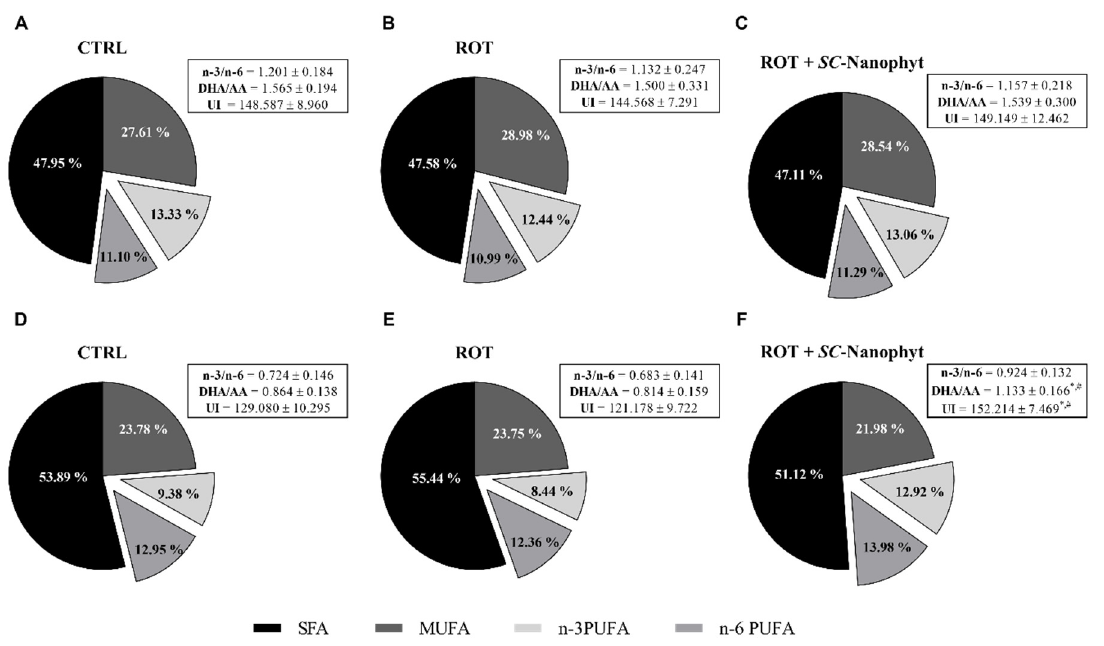
Figure 7. General parameters of the fatty acid profile of phospholipid extracts obtained from mitochondria-rich fraction from BG-Cereb ( A – C ) and C-Cortex ( D – F ) brain portions of CTRL, ROT and ROT + SC -Nanophyt groups. AA—arachidonic acid, DHA—docosahexanoic acid, SFA—saturated fatty acids, MUFA—monounsaturated fatty acids, PUFA—polyunsaturated fatty acids. * Significantly different from CTRL group, with p ≤ 0.05. # Significantly different from ROT group, with p ≤ 0.05.